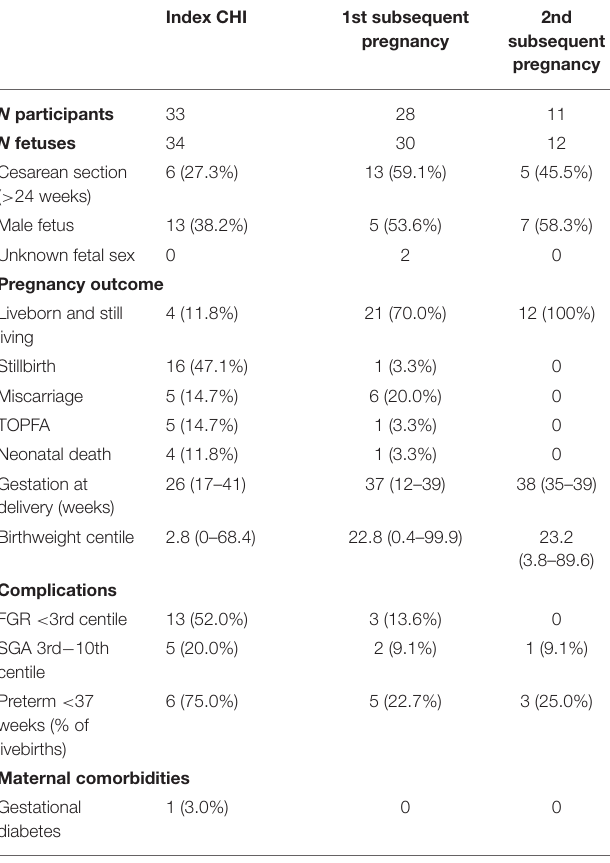
TABLE 2 | Pregnancy outcomes of index and subsequent pregnancies in women with a diagnosis of chronic histiocytic intervillositis (CHI).